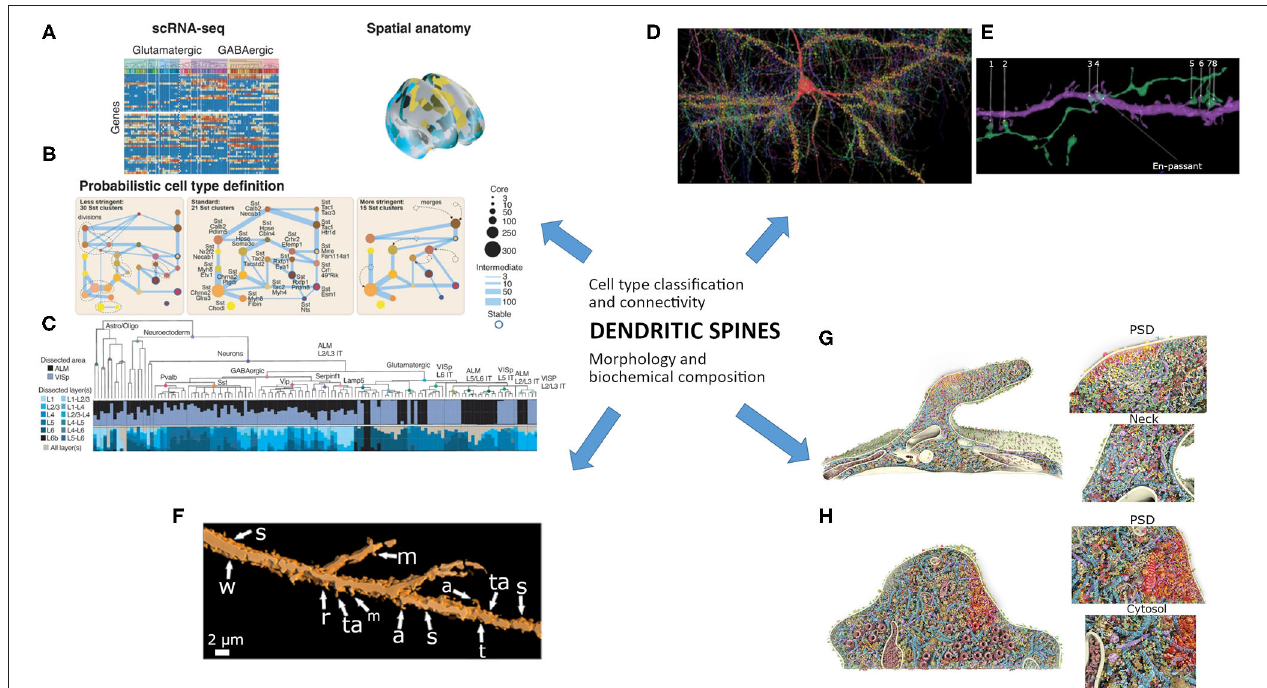
FIGURE 1 | The study of dendritic spines needs to integrate different current fields of knowledge into a coherent vision. Cell type classification and connectivity would be associated with morphology and nanoscale biochemical composition. (A–C) The probabilistic definition of a neuronal type needs that: (A) “A transcriptome-based cell-type taxonomy is constructed from scRNA-seq data, related epigenomic datasets and neuroanatomy. (B) Cell types are initially defined based on transcriptomic signatures in a probabilistic manner with multiresolution clustering and statistical analysis to identify robustness and variability. (C) Reproducible gene expression patterns identify hierarchies of putative cell types that are subject to further analyses and validation.” (A–C) are reproduced and adapted from Yuste et al. (2020) “A community-based transcriptomics classification and nomenclature of neocortical cell types” (a–c images from Figure 5 were reused without changes), Nat. Neurosci. 23, 1456–1468, doi: 10.1038/s41593-020-0685-8; used under CC BY 4.0 license and copyright. (D,E) Image of a petascale reconstruction of human parietal cortex for the study of cells and connectivity. (D) “The axonal innervation to a “pyramidal cell (red) is rendered along with all incoming synapses (yellow discs) and presynaptic axons.” (E) “Excitatory axon forming 8 synapses onto a spiny dendrite of an excitatory cell. One of these connections is en passant , the rest required directed growth of the axon to contact this same dendrite.” Note the axo-spinous contacts (numbered 1, 2, 5–8), which would be further studied by focused ion beam/scanning electron microscopy. (D,E) are reproduced and slightly adapted from Shapson-Coe et al. (2021) “A connectomic study of a petascale fragment of human cerebral cortex” (removed letters and changed number size from the original Figure 6), bioRxiv 2021.05.29.446289; doi: 10.1101/2021.05.29.446289; used under aCC-BY-NC-ND 4.0 International license and copyright. (F) Morphological features of 3D-reconstructed dendritic spines of a Golgi-impregnated neuron from the human cortical amygdala. Spine shapes include: stubby (s), wide (w), thin (t), mushroom-like (m), ramified (r), transitional (ta), atypical (a) or multiform. Reused and slightly adapted from Vásquez et al. (2018) “Neuronal types of the human cortical amygdaloid nucleus" (Figure 6e), J. Comp. Neurol. 526, 2776–2801. doi: 10.1002/cne.24527; under license # 5223180562839 from Copyright Clearance Center’s RightsLink ® originally published by John Wiley & Sons, Inc. (G,H) 3D model of dendritic spines using large-scale nanoscopy and biochemistry analysis. Multiple constitutive proteins are colored and “shown to scale, with the copy numbers and locations measured in this study and configurations according to literature. For clarity, the highly abundant monomeric actin is not shown. (G) View into a mushroom spine. Magnifications into the postsynaptic density (PSD, highlighted with red glow) and neck are depicted. (H) View into a stubby spine. Again, a magnification of the PSD is shown and a zoom into the cytosolic region of the spine.” Reused and slight adaptation from Helm et al. (2021) manuscript) after